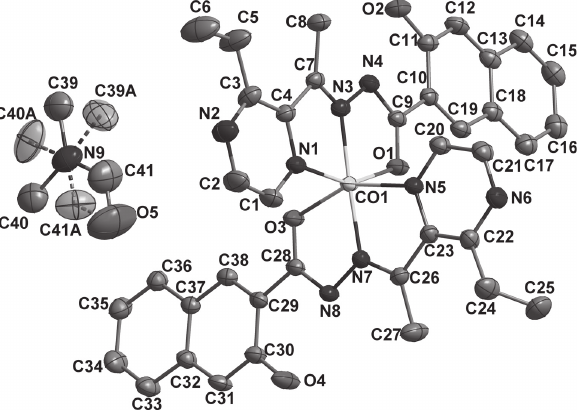
Table 2: Fractional atomic coordinates and isotropic or equivalent isotropic displacement parameters (Å 2